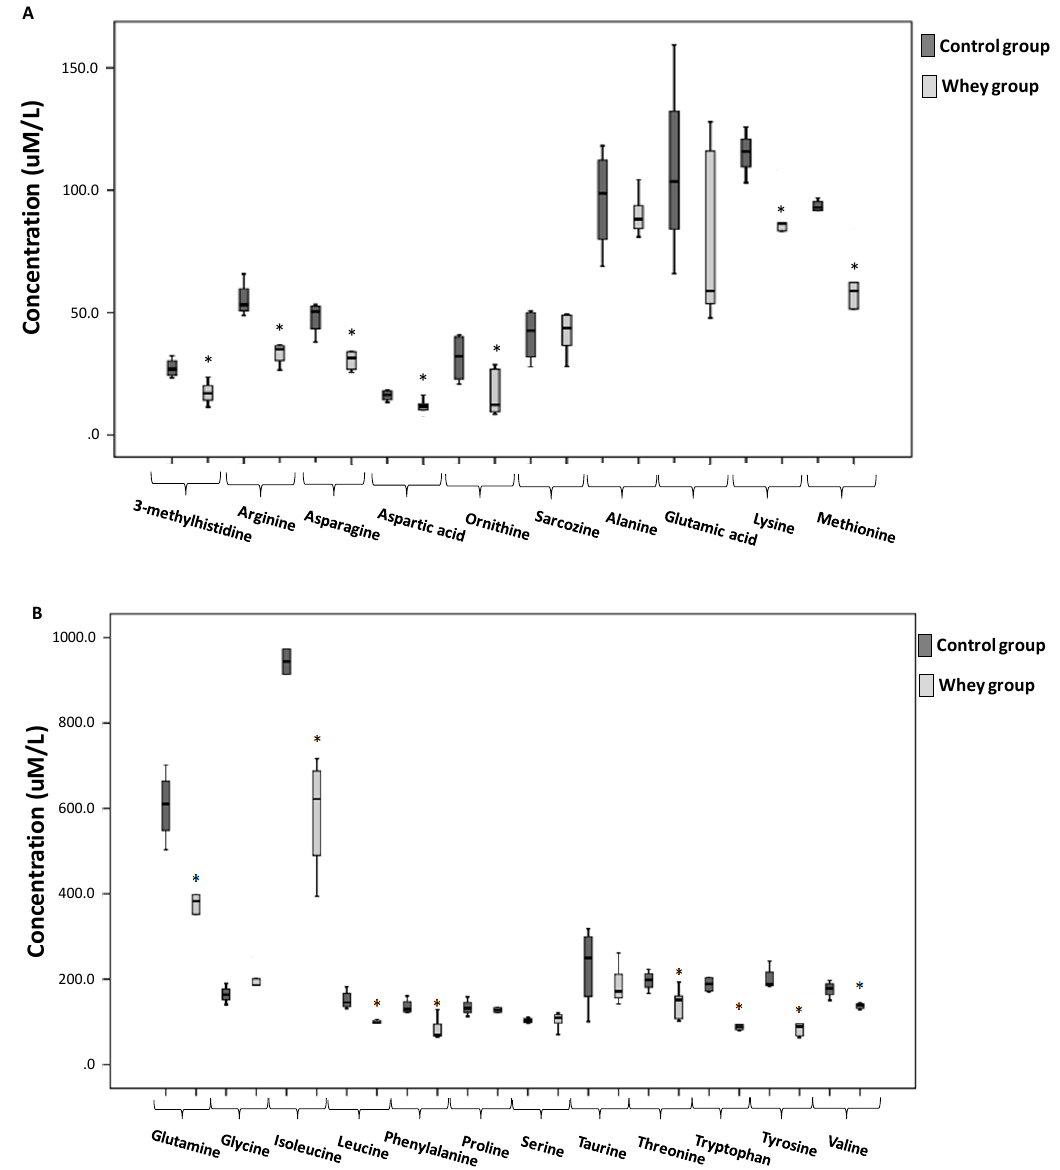
Figure 3. The boxplots illustrating the effects of sheep/goat whey protein administration on the plasma amino acid levels of rats. ( A ): 3-methylhistidine, arginine, asparagine, aspartic acid, ornithine, sarcosine, alanine, glutamic acid, lysine and methionine ( B ): glutamine, glycine, isoleucine, leucine, phenylalanine, proline, serine, taurine, threonine, tryptophan, tyrosine and valine. *: Statistically significant compared to the control group ( p < 0.05).